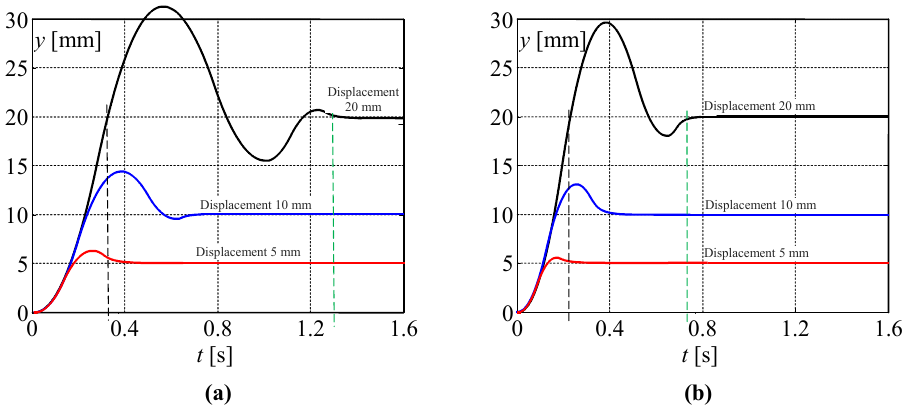
Figure 9. The servo drive controlled using an overshoot-free algorithm step response. ( a ) With one stepping motor. ( b ) With two stepping motors.